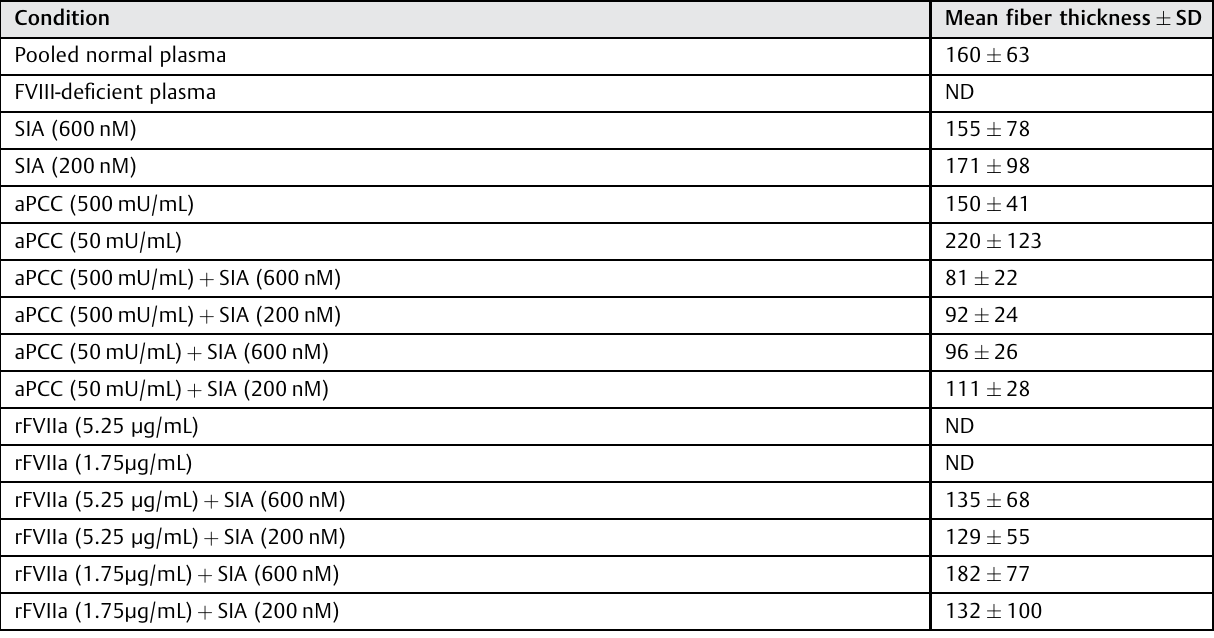
Table 2 Fiber thickness of the representative fi ber clots Condition